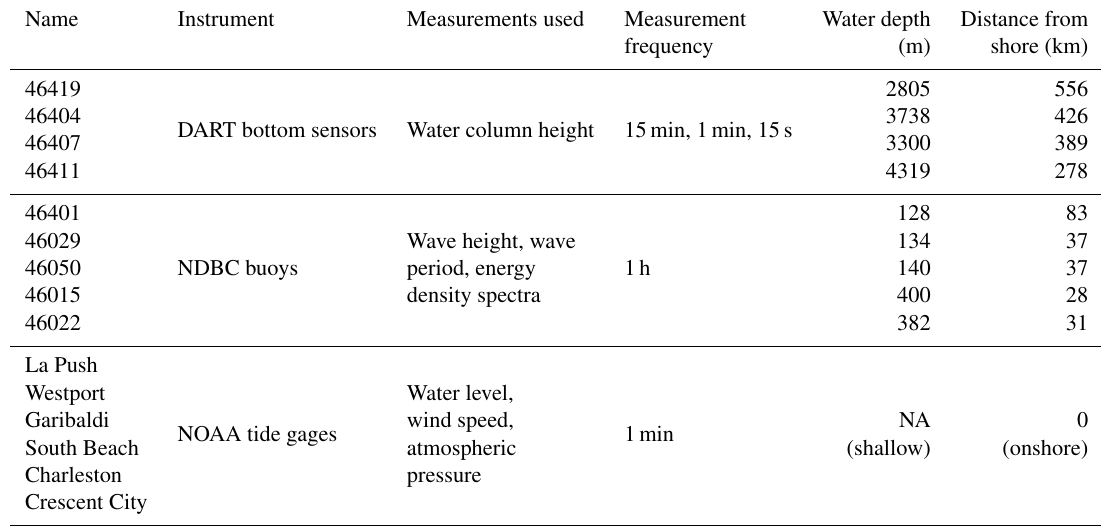
Table 1. List of observations with their locations and additional information (water depth, distance to coast, data used).